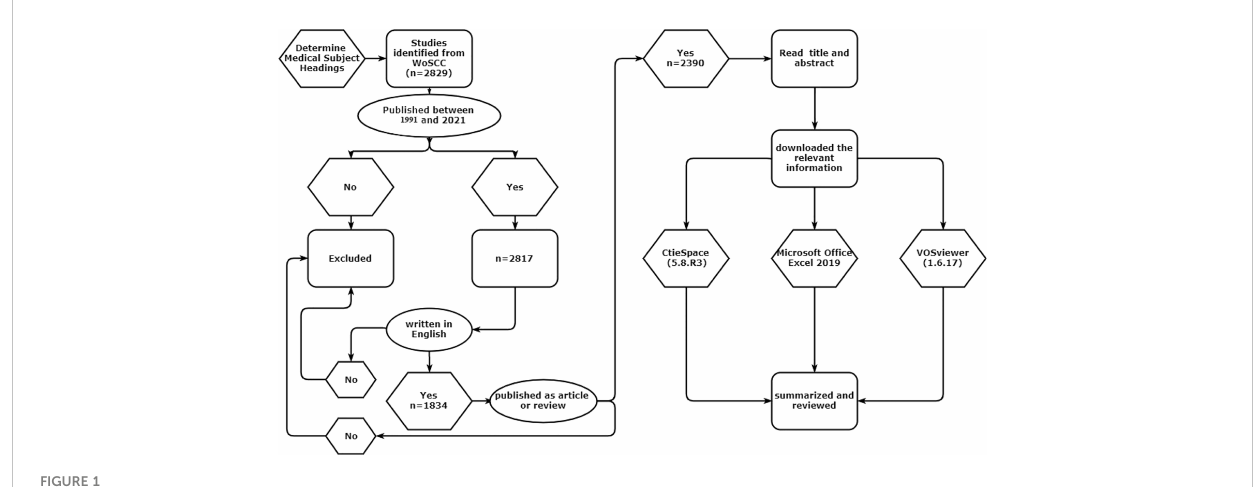
FIGURE 1 Literature screening and analysis